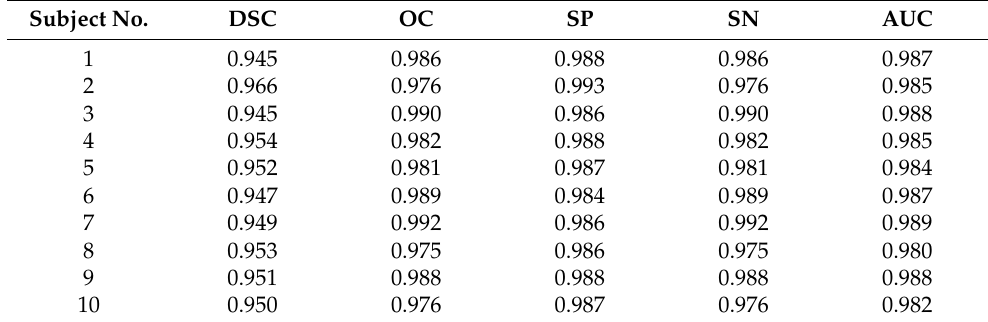
Table A2. Evaluation results for cerebellar tissue with fissures (model M2) on Hammers subset.